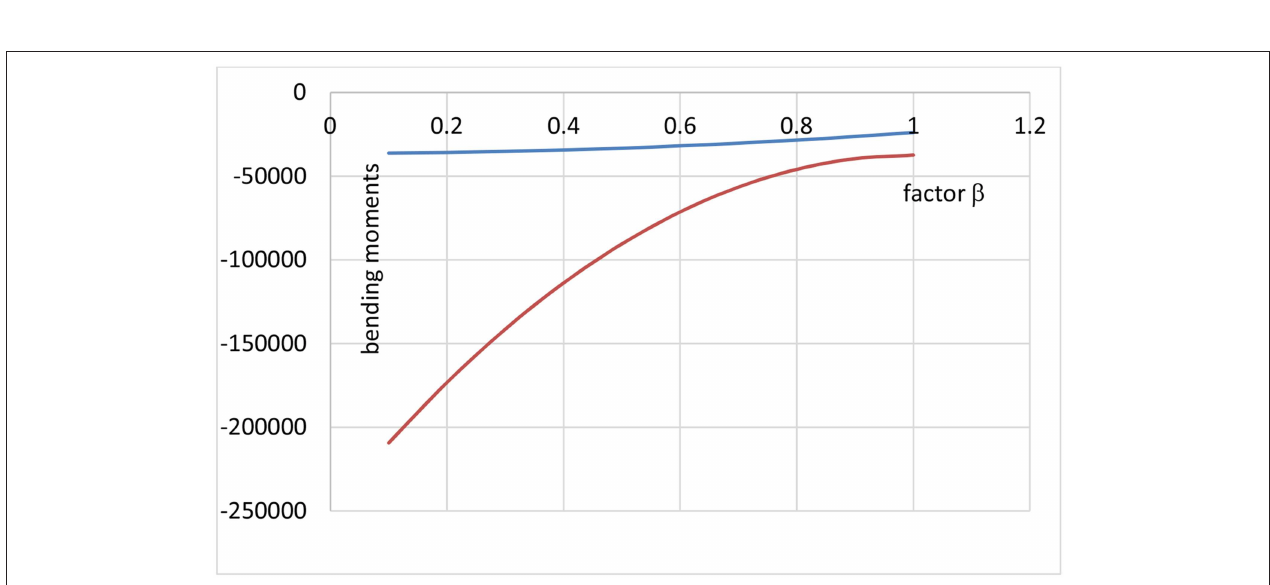
FIGURE 11 | Cantilevering bending moments as a function of β .